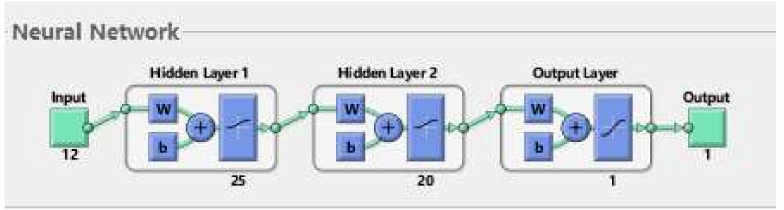
Figure 22. A back propagation (BP) neural network